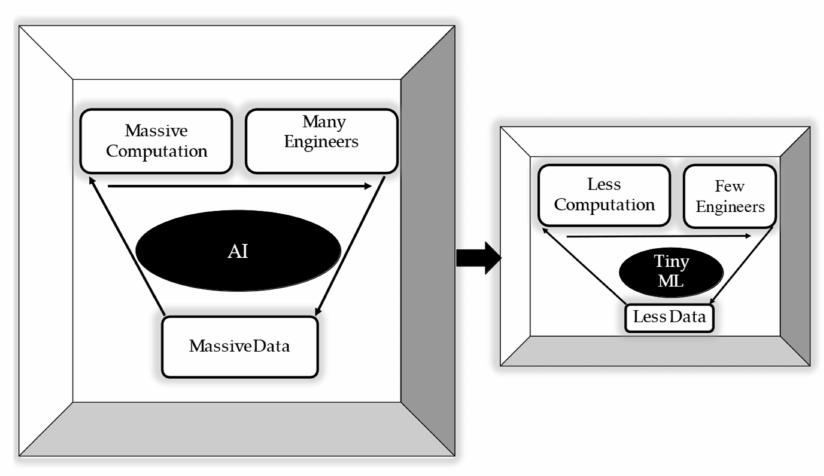
Figure 5. From AI to tiny ML with significant benefits for healthcare